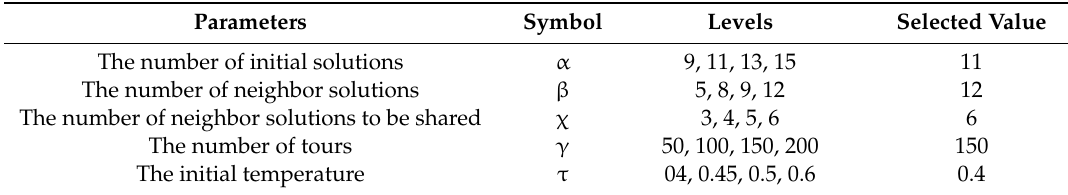
Table 8. Selected parameter values of the proposed IMBO.